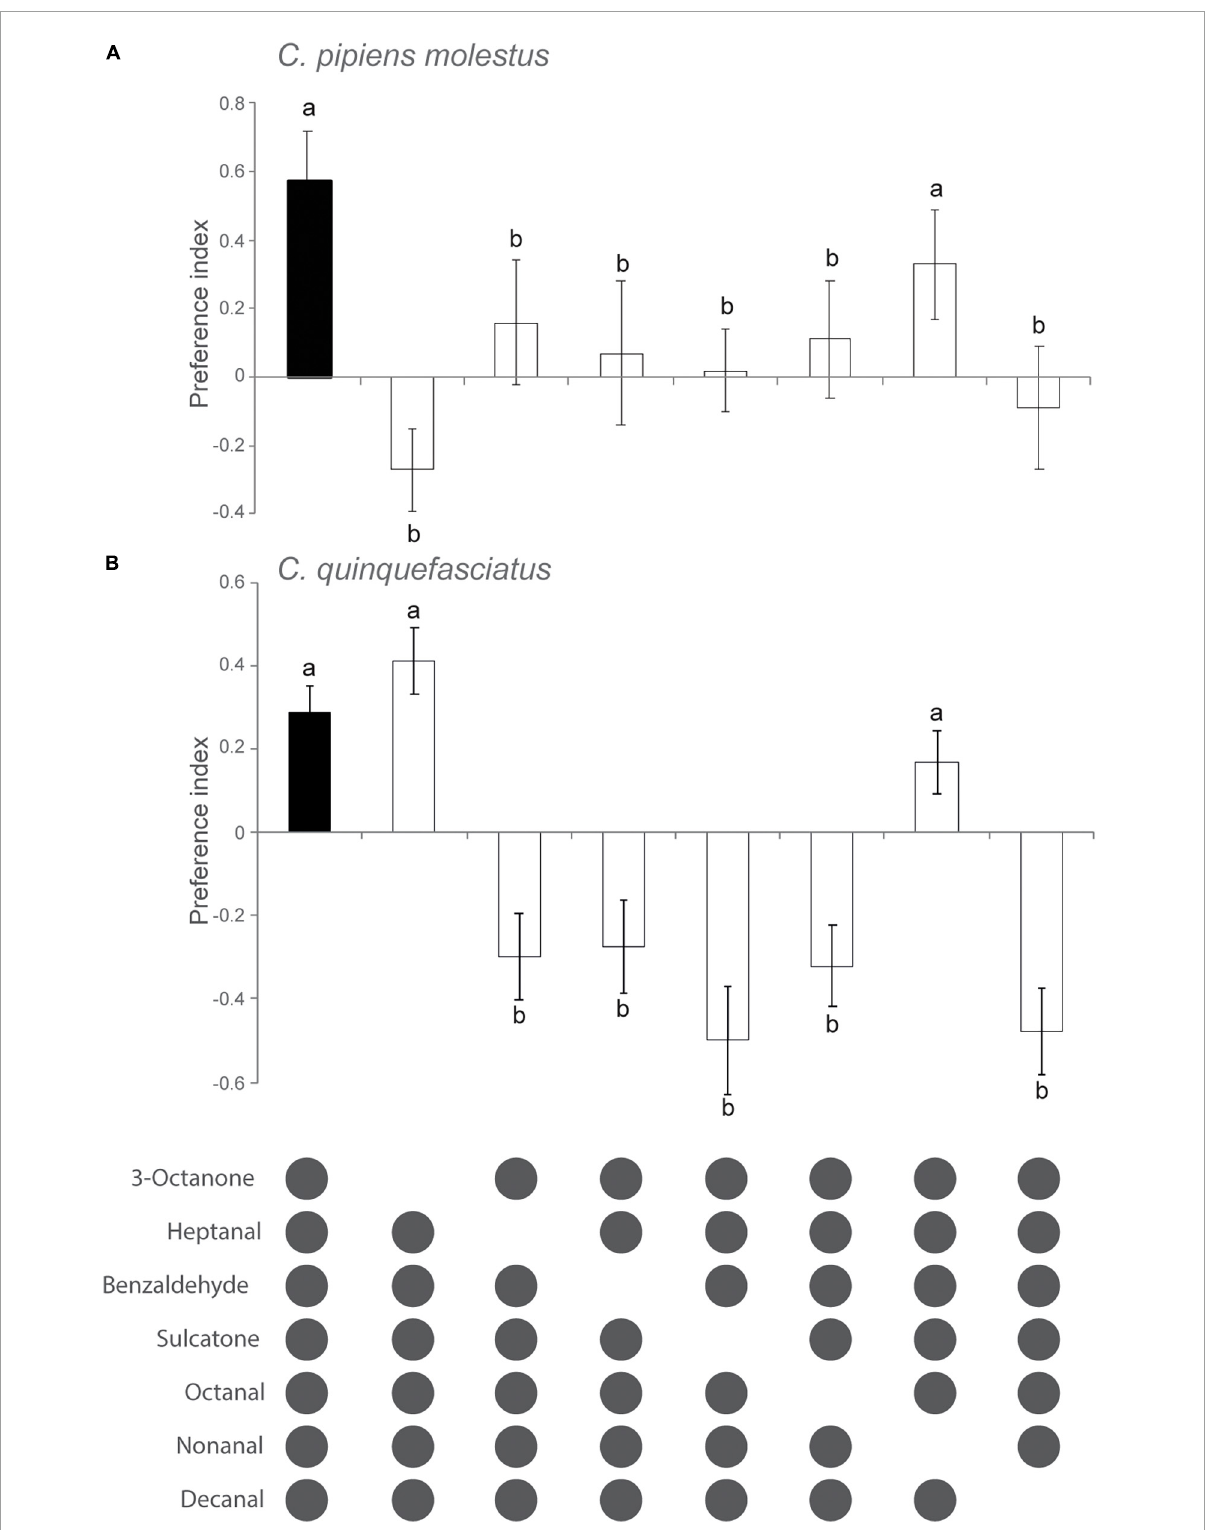
FIGURE2 Behavioral responses of host-seeking Culex pipiens molestus (A) and Culex quinquefasciatus (B) to subtractive blends based on chicken odor. Attraction to the full chicken blend was generally significantly reduced compared to that of the full chicken odor blend, as demonstrated using a generalized linear model followed by Dunnett’s post-hoc tests. Different lowercase letters indicate significant differences in attraction between the subtractive blend and the full chicken odor blend. The preference index was calculated as (T − C)/(T + C), where T is the number of mosquitoes associated with the test odor, and C the number of mosquitoes associated with the control. Error bars denote standard error of the